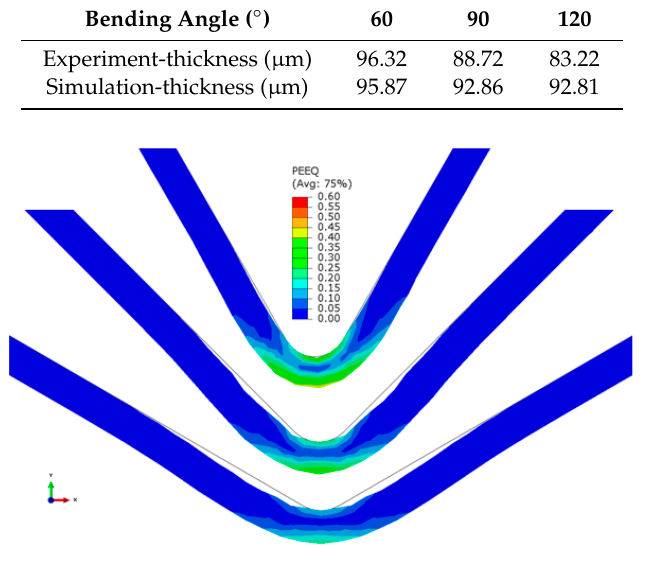
Figure 12. Equivalent strain distribution of finite element model. Table 3. The thickness of round corner after springback for Cu/Ni with a bending angle of 60°. Annealing Temperature (°C)